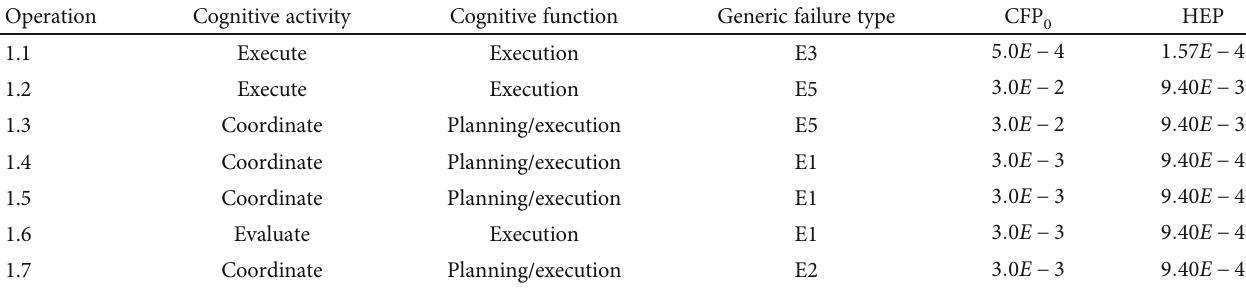
Table 9: HEPs for approach operations.